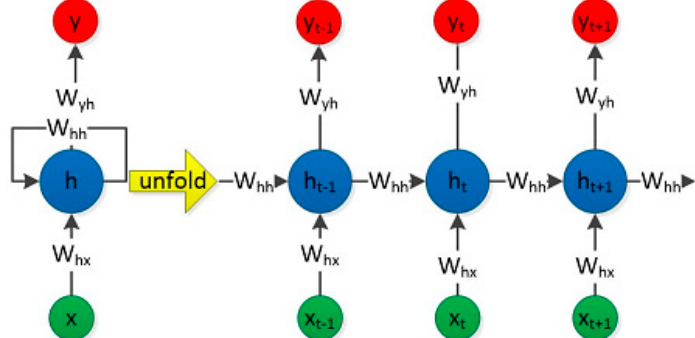
Figure 5. Unfolding of Recurrent Neural Network (RNN) [38].